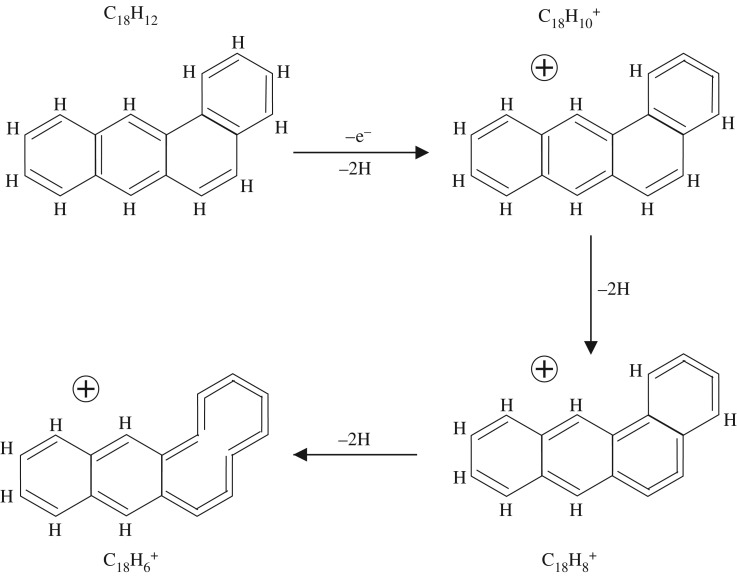
A proposed pathway for the dehydrogenation of C18H12 (S4) benz[a]anthracene to C18H 6+. A further single hydrogen atom dehydrogenation would then form a C18H 5+ ion.